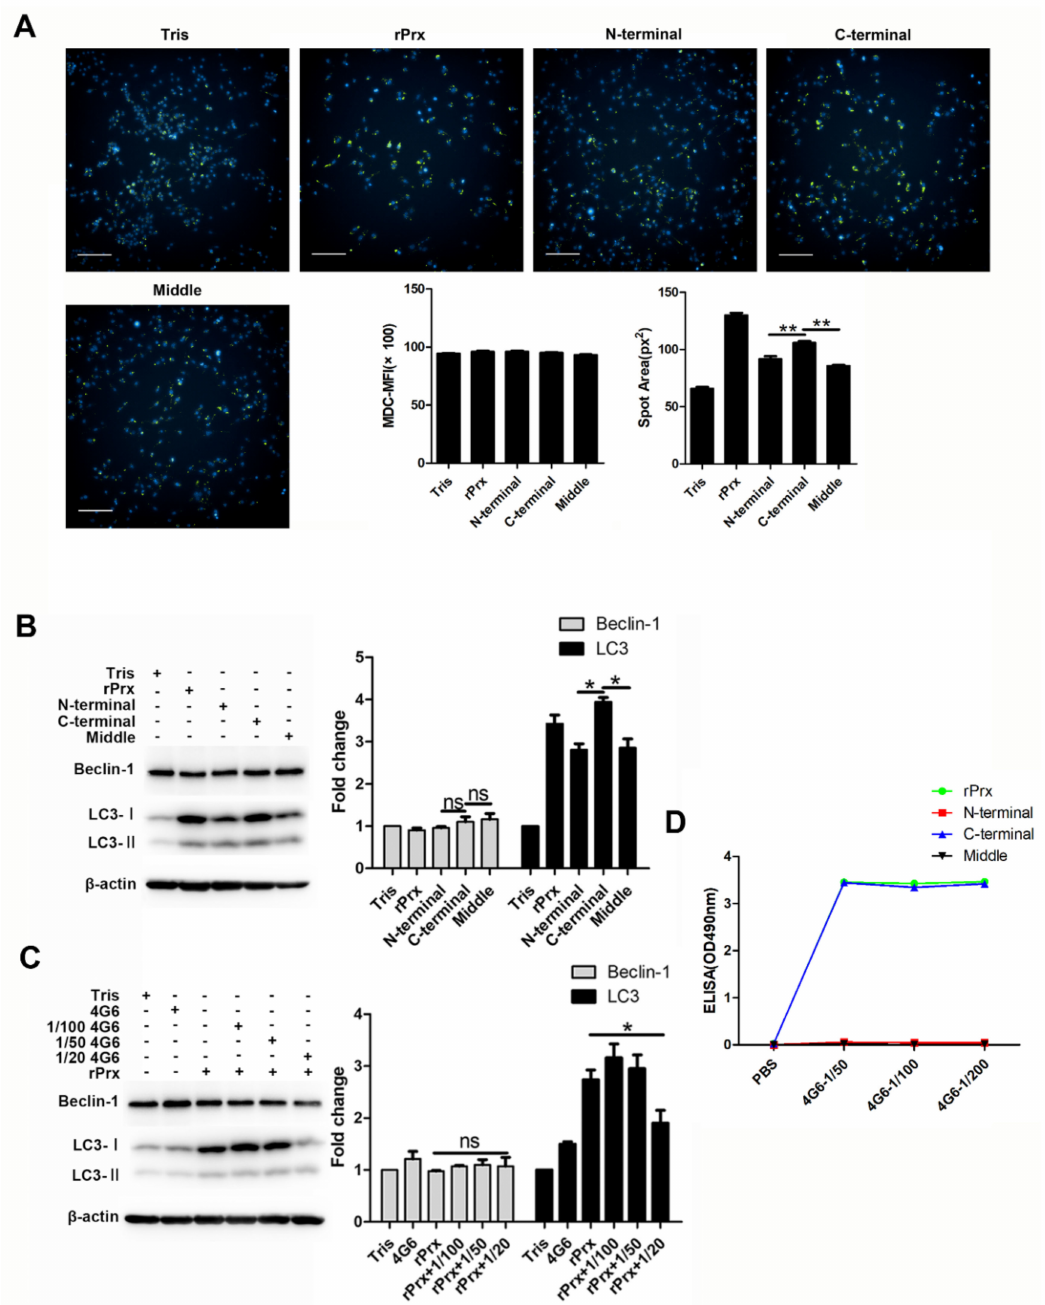
Figure 4. The Eh -rPrx C-terminal was the principal domain responsible for autophagy activation. ( A ) The C-terminal of Eh -rPrx induced autophagosome formation. RAW264.7 cells were incubated with 5 µ g / mL of full-length Eh -rPrx or its N-terminal, middle, or C-terminal fragments for 24 h and then stained with MDC (green) and Hoechst 33342 (blue). The spot area of MDC fluorescence was quantified using high-content screening analysis ( n = 5). Scale bar: 100 µ m. ( B ) Eh -rPrx C-terminal fragment activated autophagy. RAW264.7 cells were treated as in ( A ) and analyzed for the expression of Beclin-1 and LC3 by Western blotting ( n = 3). ( C ) Autophagy activation by Eh -rPrx was inhibited by mAb 4G6. RAW264.7 cells were pre-treated with di ff erent concentrations of mAb 4G6, incubated with Eh -rPrx (5 µ g / mL) for 24 h, and analyzed for the protein expression of Beclin-1 and LC3 by Western blotting ( n = 3). ( D ) Eh -rPrx C-terminal fragment contained the recognition site for mAb 4G6. The reaction of full-length Eh -rPrx or its N-terminal, middle, or C-terminal fragments with mAb 4G6 was analyzed by ELISA. The data are expressed as the mean ± SEM; * p < 0.05 and ** p < 0.01 by Student’s t -test; ns, not